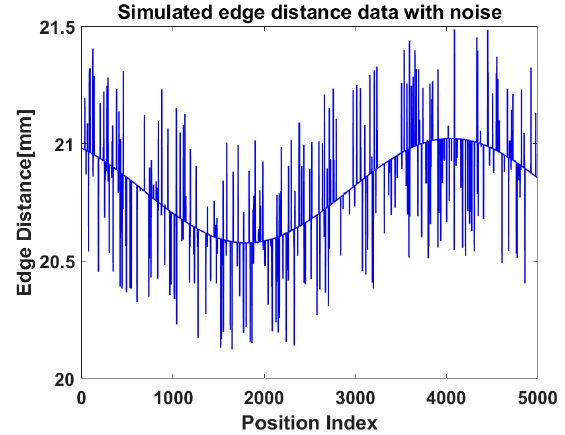
Figure 10. Simulated edge distance data with outliers.